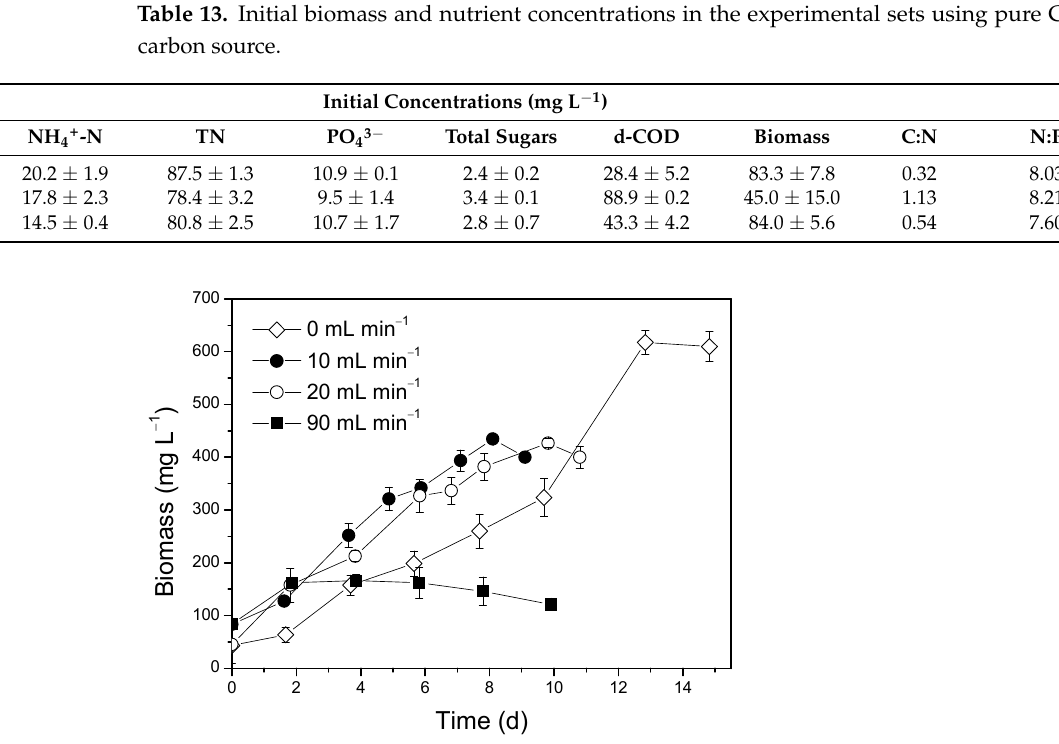
Table 13. Initial biomass and nutrient concentrations in the experimental sets using pure CO 2 as carbon source.